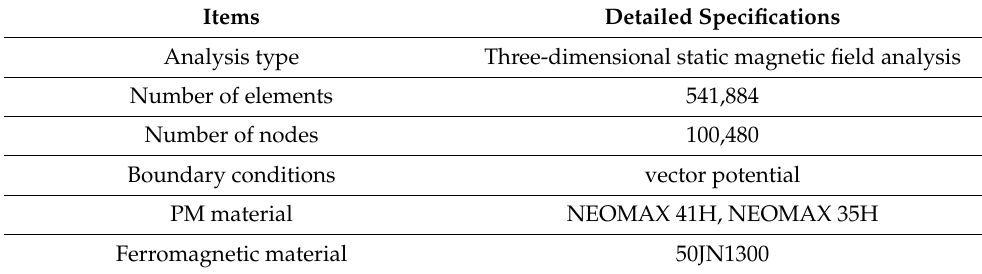
Figure 4. One-quarter of the model used for simulation. Table 2. Simulation conditions.